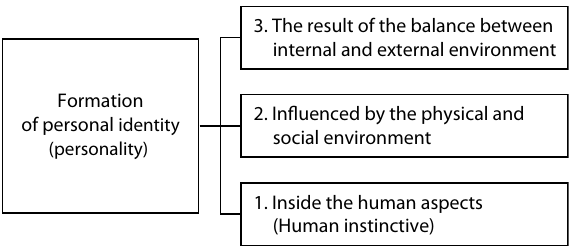
fig. 6. formation of personal identity,